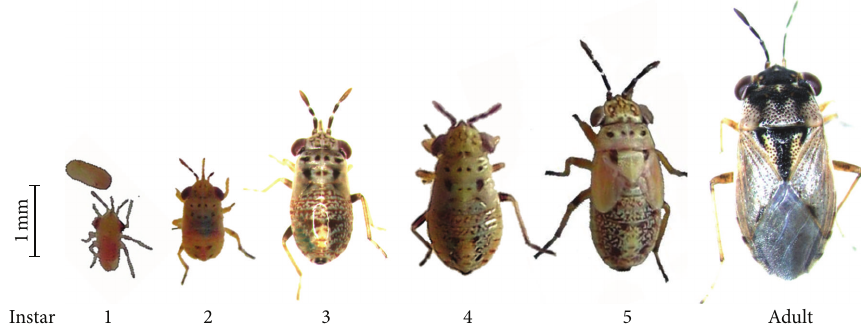
Figure 2: Larval and adult stages of G. pallens from the Great Basin Desert in southwestern Utah. Geocoris spp. have five nymphal instars.